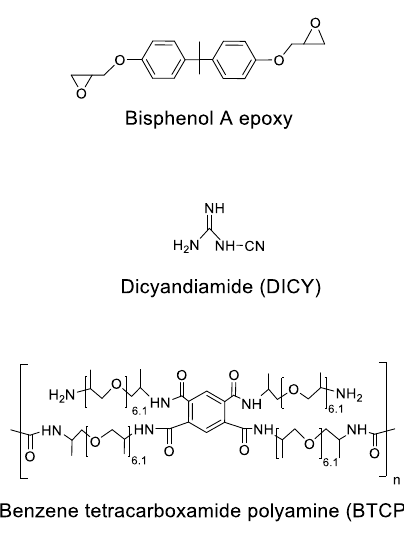
Figure 1. Chemical structures of the epoxy resin (Bisphenol A), curing agent (DICY) and